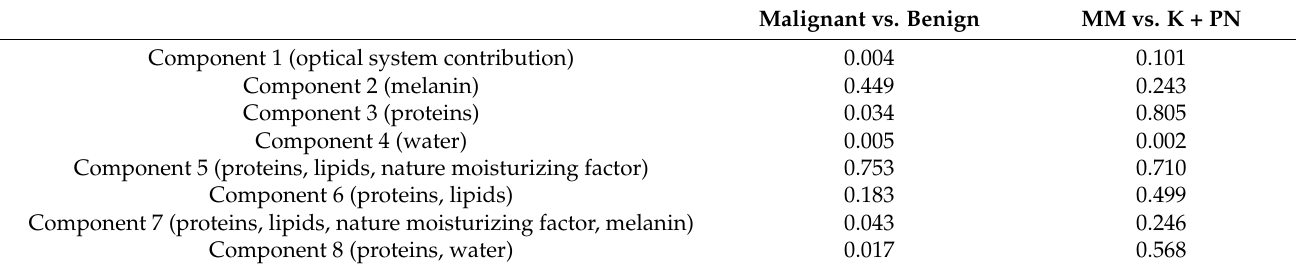
Table 1. The significance values ( p -values) for component concentration calculated at the first step of logistic regression. The p -values for the coefficients indicate whether these relationships are statistically significant. If the p -value for a variable is less than the significance level of 0.05, this variable is statistically significant. Bold type in the table indicates cases of binary logistic